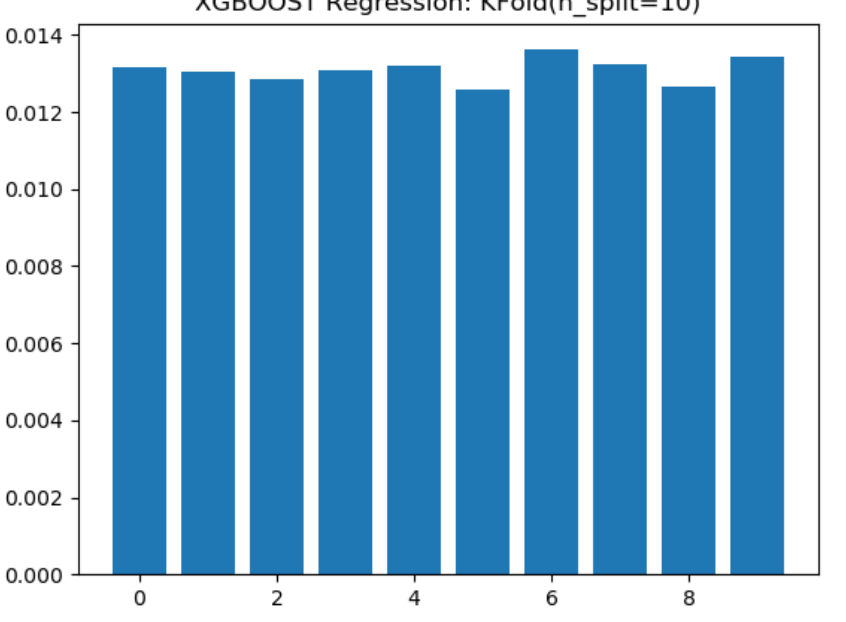
Figure 12. Performance of XGBoost algorithm. Table 3. Scores for Xgboost